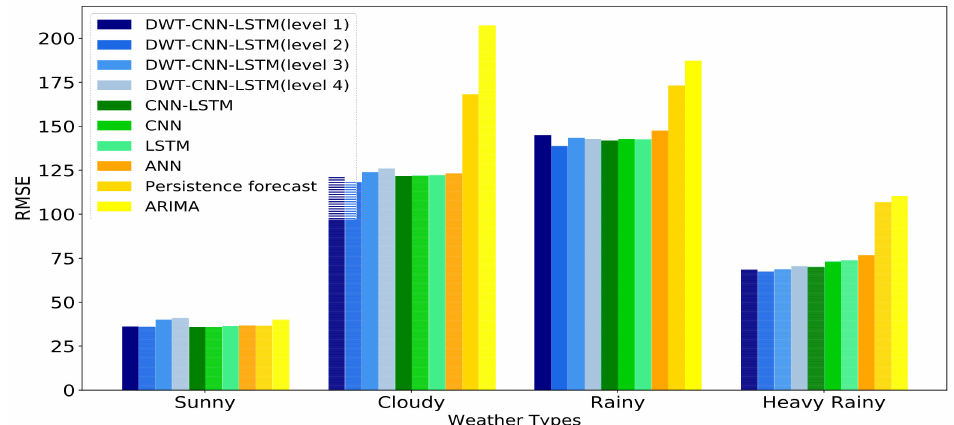
Figure 12. The RMSE of different forecasting models for sunny, cloudy, rainy and heavy rainy days using the dataset of Elizabeth City State University.